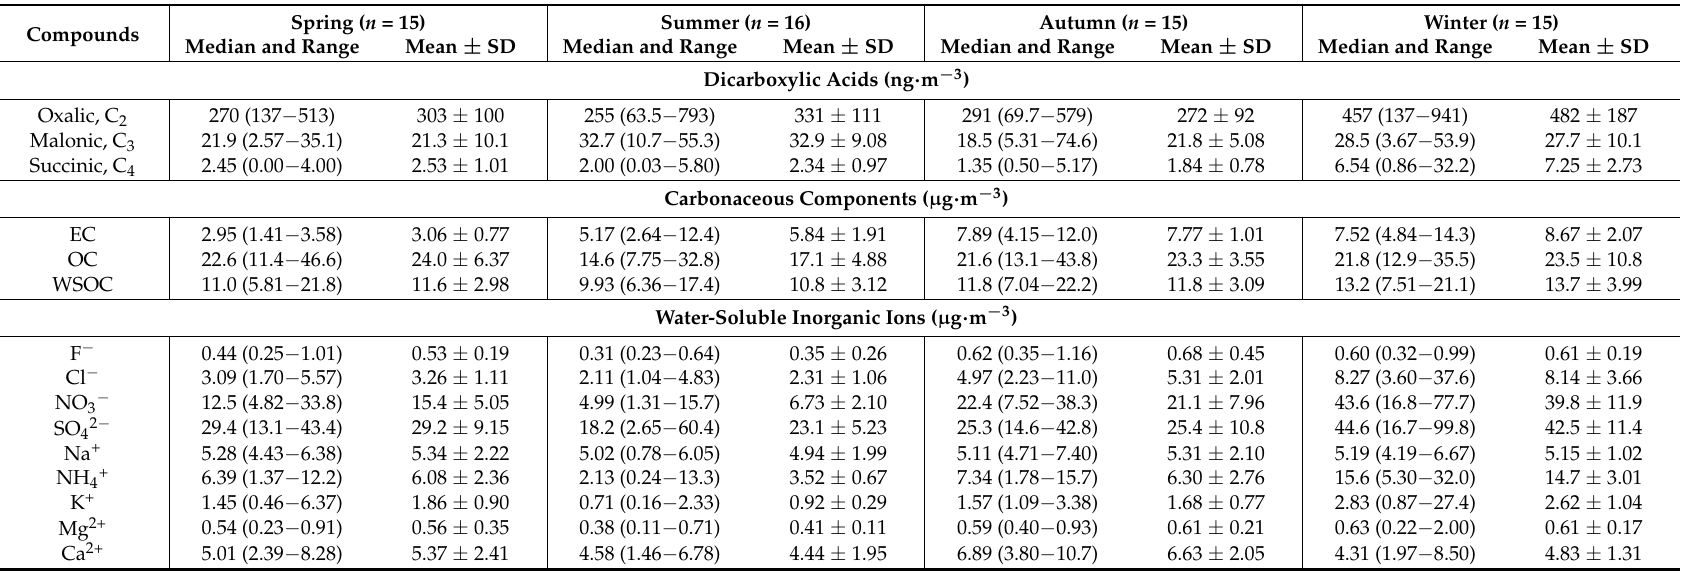
Table 1. Concentrations of dicarboxylic acids, carbonaceous components, and water-soluble inorganic ions in PM 10 collected from Huangshi, Central China during April 2012 to March